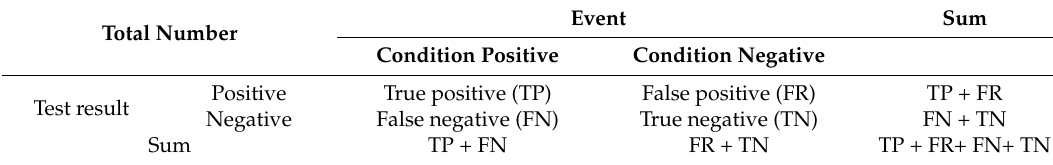
Table 4. Contingency table of calculation of ROC curve.